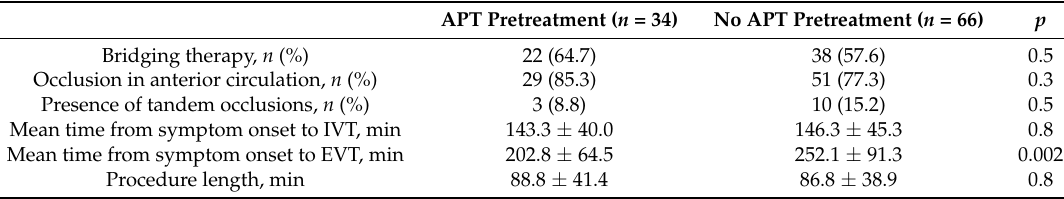
Table 2. Information on endovascular therapy